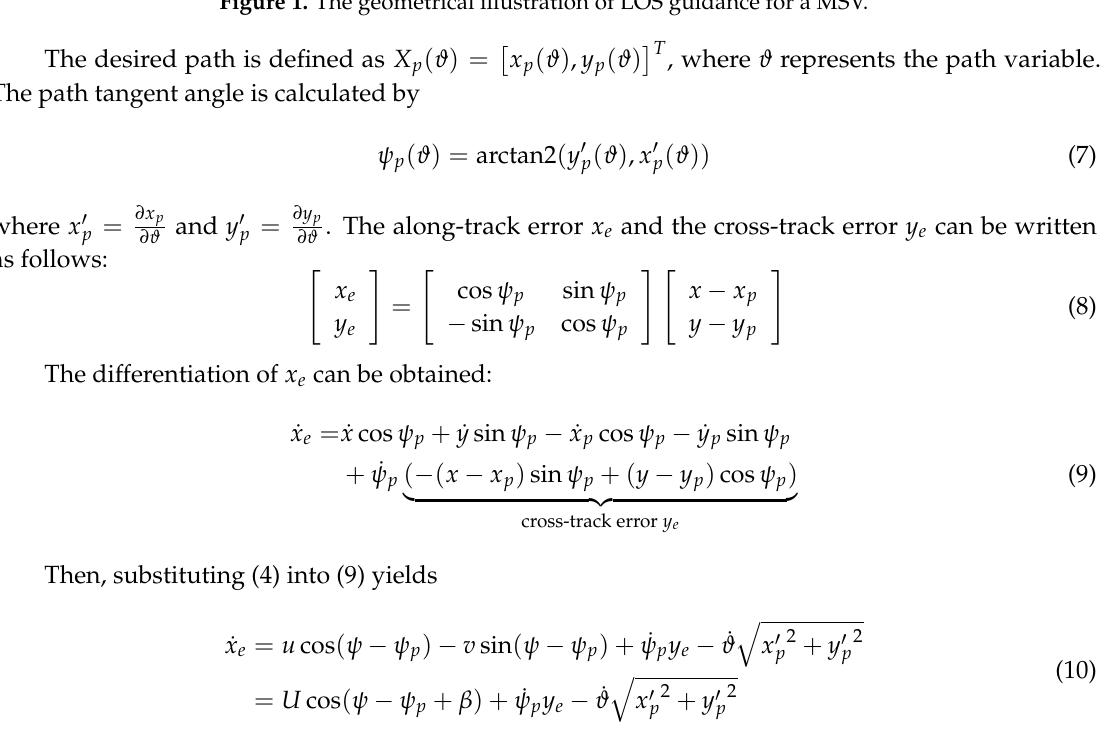
Figure 1. The geometrical illustration of LOS guidance for a